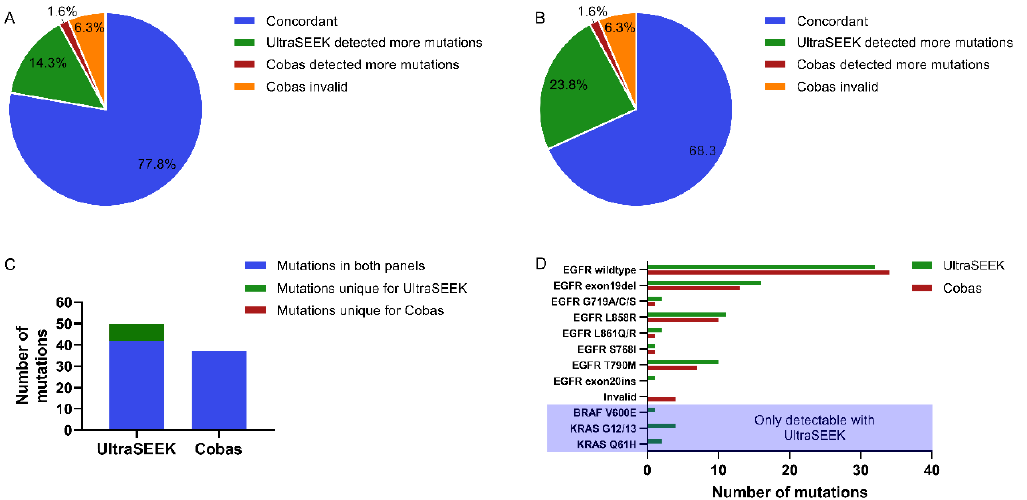
Figure 4. Comparison of mutation detection between UltraSEEK ™ and Cobas ® with harmonized sample input. Pie charts representing the samples which were concordant between UltraSEEK ™ and Cobas ® (blue), samples in which UltraSEEK ™ detected more mutations (green), samples in which Cobas ® detected more mutations (red), and sample of which the Cobas ® analysis was invalid supposedly due to insu ffi cient input (purple) for ( A ) the mutations detectable on both panels and ( B ) all clinically relevant mutations. ( C ) Bar graph illustrating the total amount of mutations detected in all samples. The blue bar represents the number of mutations that could be detected on both panels; the green bar represents detected mutations unique for the UltraSEEK ™ Panel. No mutations only covered by the Cobas ® Panel were detected (red bar). ( D ) Bar graph illustrating frequency of detection per mutation with UltraSEEK ™ (green) and Cobas (red). Table 4. Concordance of mutation detection related to the harmonized ccfDNA input.